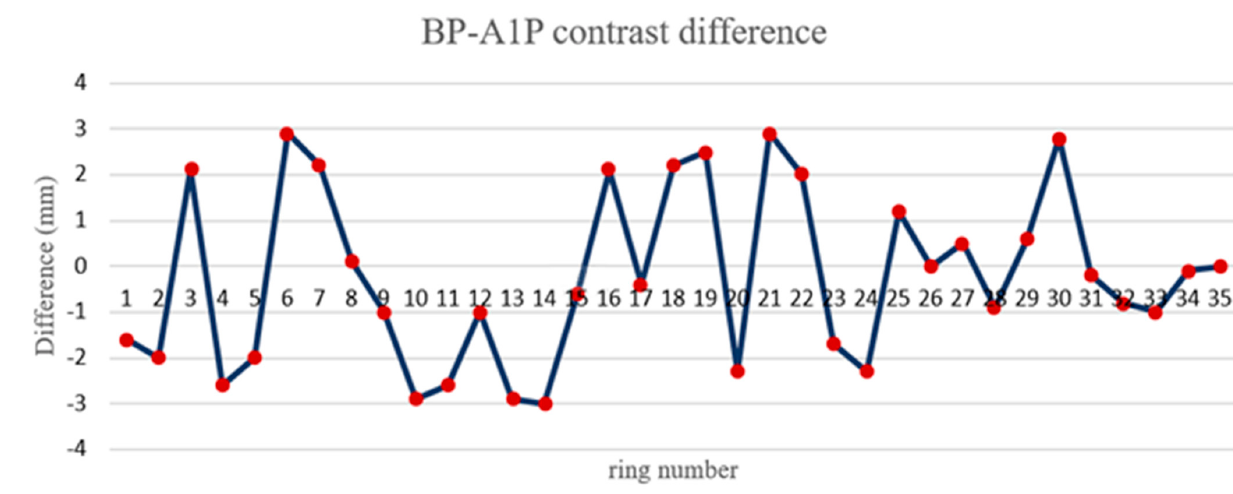
Figure 15. Circumferential displacement contrast difference.